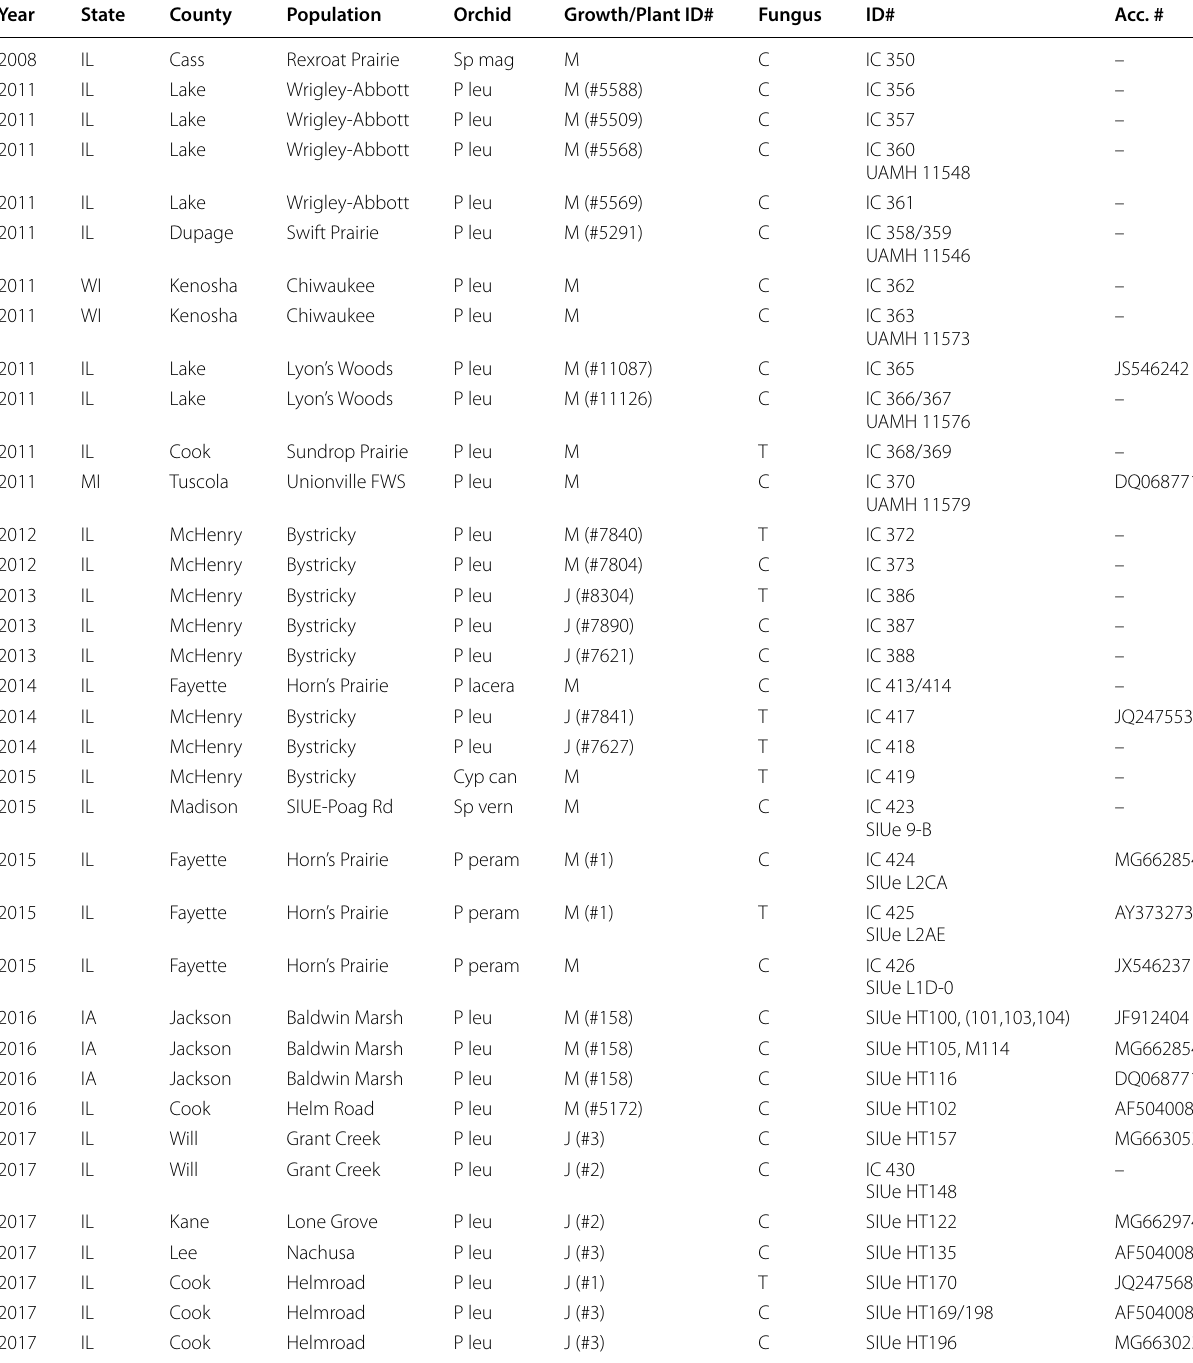
Table 1 A summary of the orchid endophytes recovered from orchids inhabiting tallgrass prairies during the